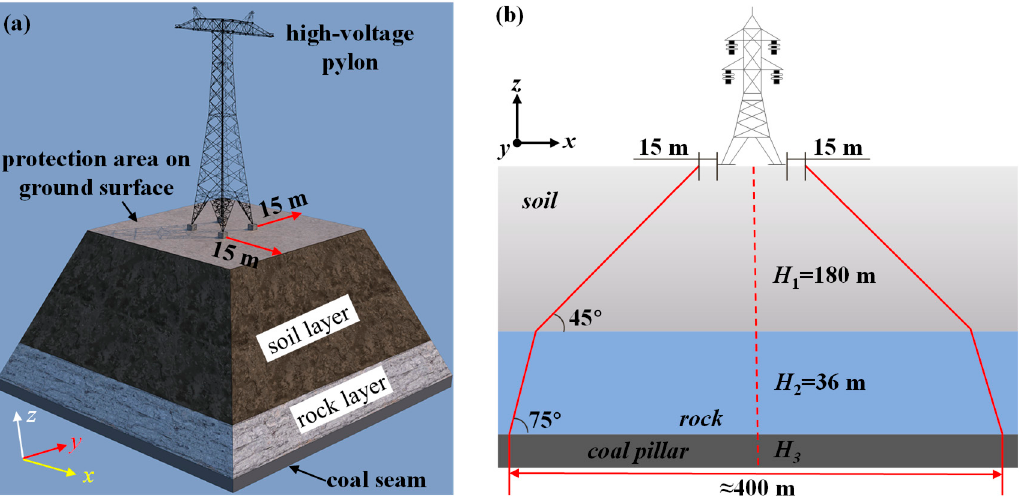
Figure 1. Schematic diagrams of the protection area and geotechnical protection layers designed for high-voltage pylons constructed in mining areas. ( a ) Protection area on ground surface and ( b ) area of the geotechnical protection layers. Based on requirements of the literature [12].